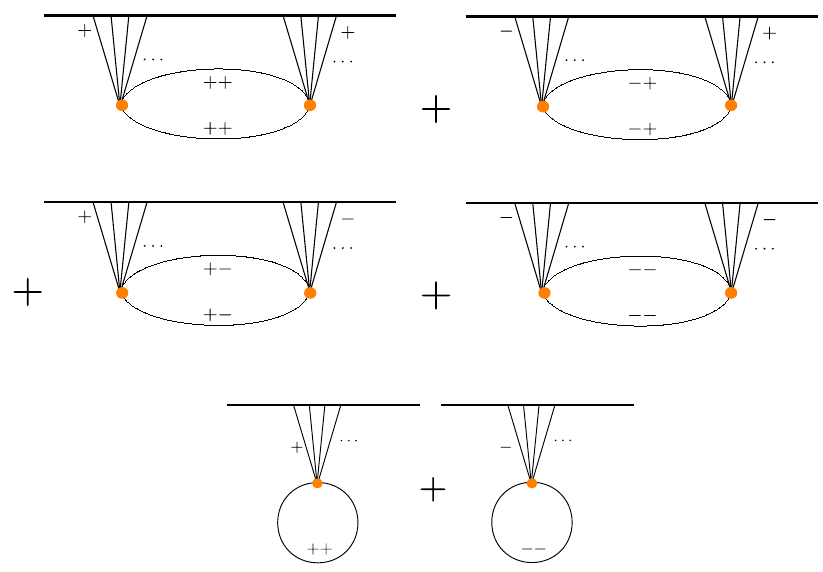
Figure 7 . Analytically-continued dS 4 diagrams contributing to bulk and boundary divergences in the one-loop effective action. Internal lines are elements of the ˆ G